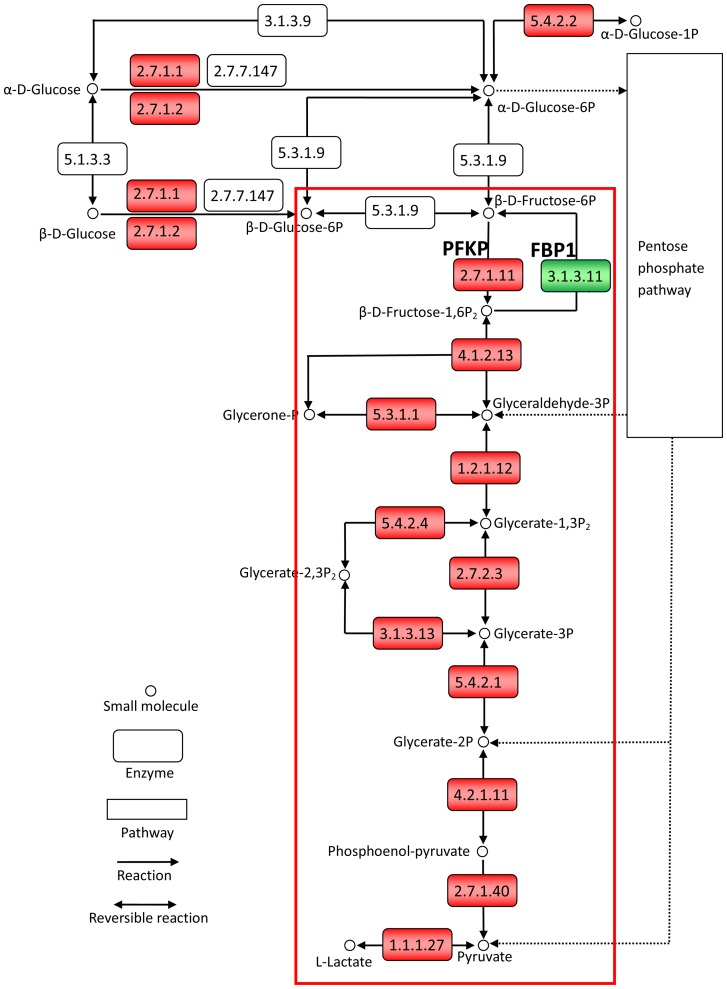
Upregulation of PFKP and downregulation of FBP1 contribute to ER− breast cancers.ER− DE genes in the glycolysis/gluconeogenesis pathway are denoted in red for upregulation and in green downregulation. The red frame indicates the elevated anaerobic glycolysis subpathway in ER− cancers. The figure is created based on KEGG pathway hsa00010. Only a part of the pathway is shown for clarity.